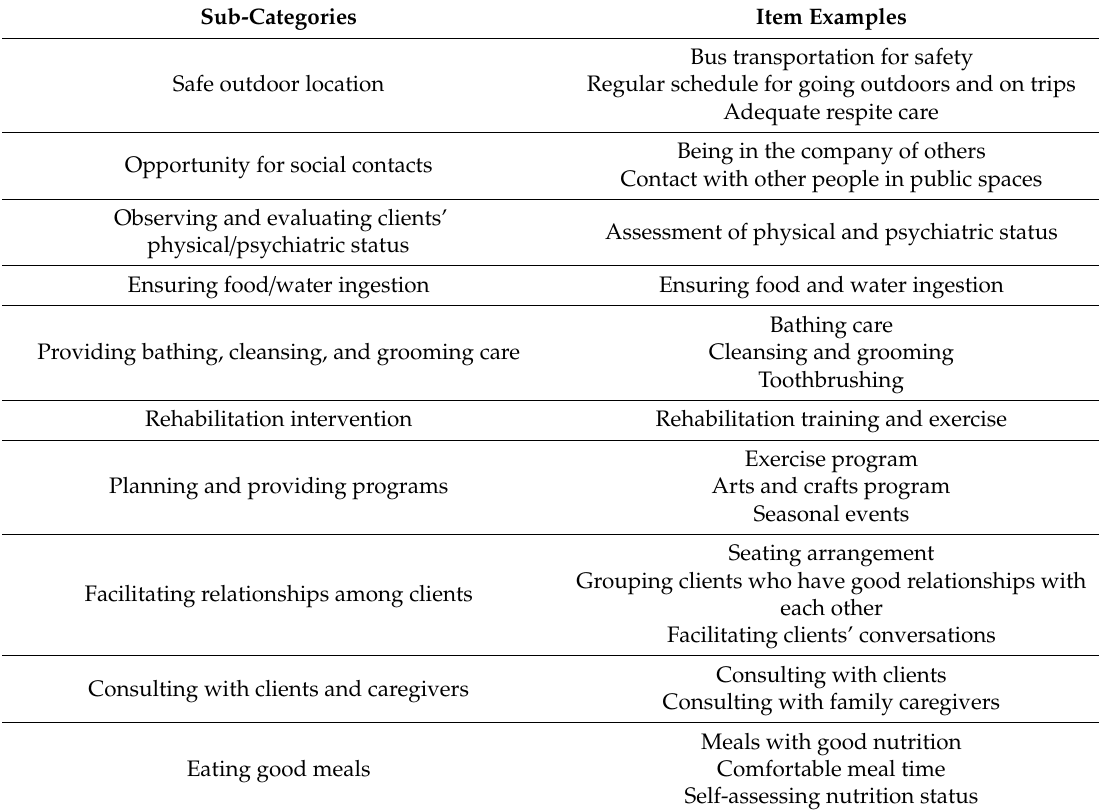
Figure 1. Developed Logic Model of Adult Day Care Service. Shown are the categories and sub-categories for the logic model of adult day care services. Categories (shown by <…>) and sub-categories are shown. Arrows indicate “cause and effect.”. Table 1. Sub-Categories and Item Examples.